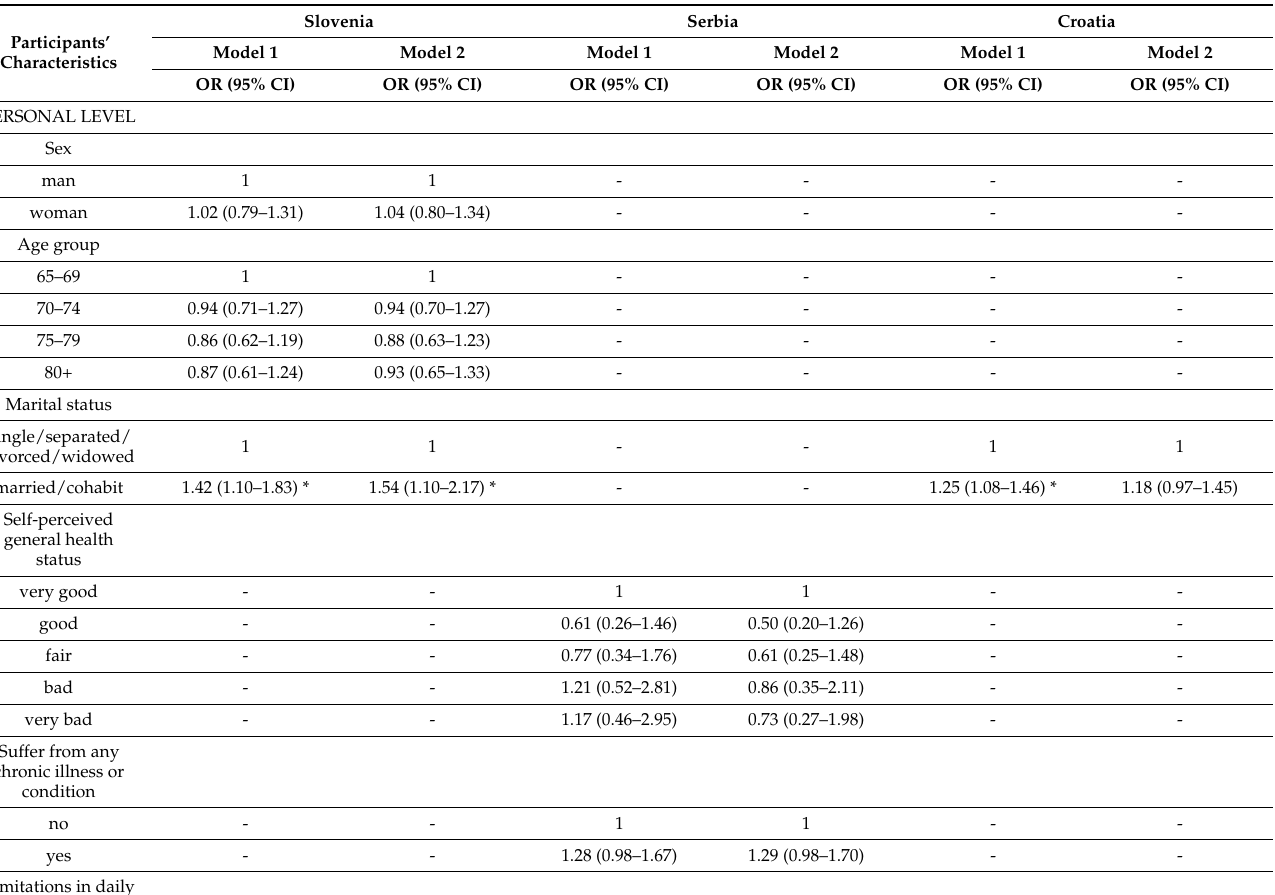
Table 8. Multivariate logistic regression models for the financial burden of